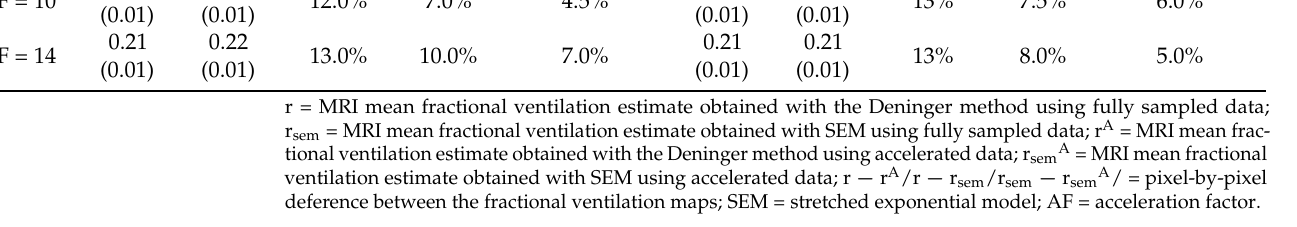
Table 3. 19 F MRI-based Fractional-Ventilation Measurements (average from all rats). FGRE